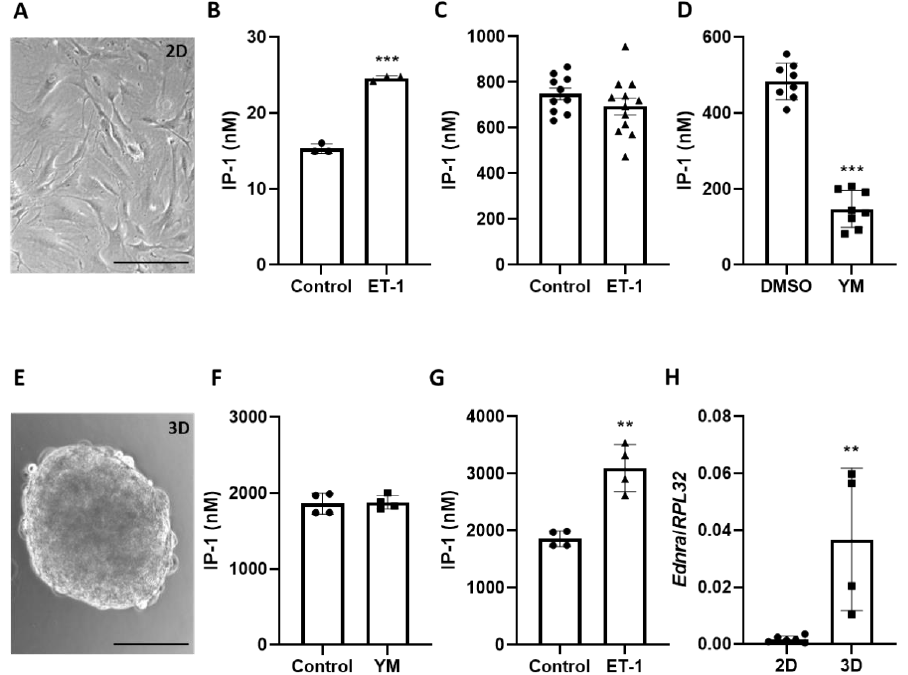
Figure 1. Comparison of ET-1-dependent G α q -protein signaling in 2D and 3D VSMC. ( A ) Representative phase-contrast image (20-fold magnification) of murine aoSMC cultured as a 2D monolayer (scale bar: 100 µ m). ( B – D ) Analyses of the IP-1 level in ET-1-treated (100 nM) murine aortas (( B ), n = 3, *** p < 0.001) and in aoSMC cultured as monolayer upon ET-1 treatment (( C ), n = 10–12, data were normalized to total protein levels) or treated with the G α q/11 inhibitor YM-254890 (10 µ M) (( D ), n = 8, *** p < 0.001). ( E ) Representative phase-contrast image (20-fold magnification) of aoSMC cultured as 3D spheroids (scale bar: 100 µm). ( F , G ) IP-1 level measured in 3D aoSMC treated with YM-254890 (( F ), n = 4) or ET-1, (( G ), n = 4, ** p < 0.01). ( H ) Ednra expression was determined by qPCR in RNA samples isolated from 2D or 3D cultured murine aoSMC (n = 4 – 5, ** p < 0.01, RPL32 was used as reference).